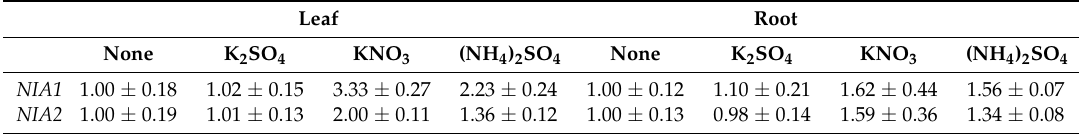
Table 1. Relative transcript levels of NIA1 and NIA2 in the leaves and roots of WT plants supplied with specific nitrogen source.